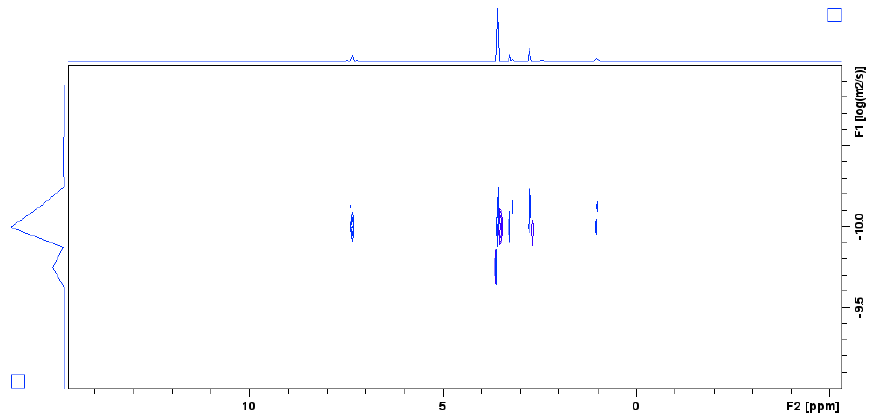
Figure 3. DOSY NMR spectrum recorded on silica NP grafted with PEG and the La-complex. The diffusion time ∆ was set at 600 ms.